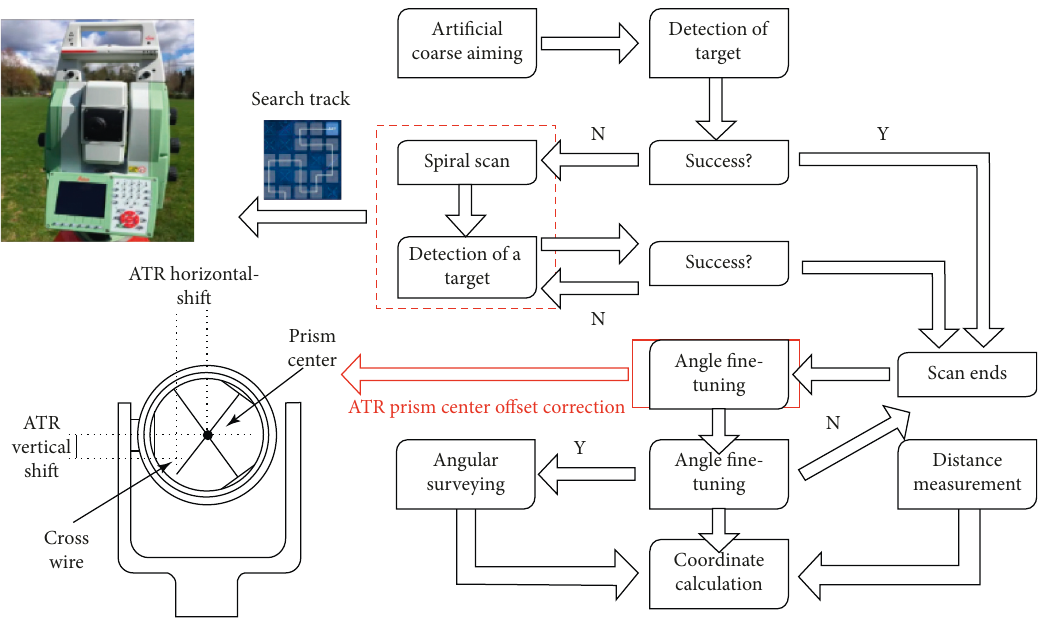
Figure 8: Workflow diagram of robot intelligent detection. Table 1: Error table of three-dimensional coordinate components of monitoring